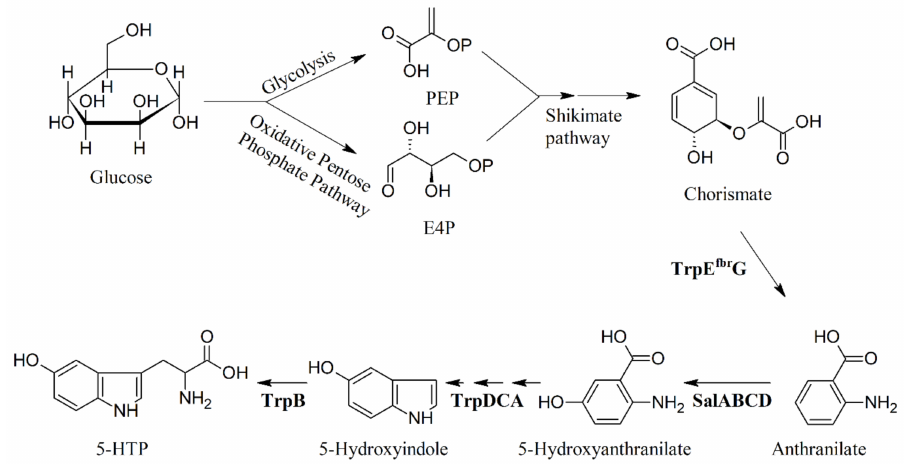
Figure 8. Production of 5-HTP from glucose in engineered E. coli by using a novel salicylate 5- hydroxylase. PEP, phosphoenol pyruvate; E4P, erythrose-4-phosphate; TrpE fbr G, anthranilate syn- thase (from a feedback resistance mutant); SalABCD, salicylate 5-hydroxylase; TrpDCA and TrpB, E. coli native tryptophan biosynthetic enzymes. Adapted from